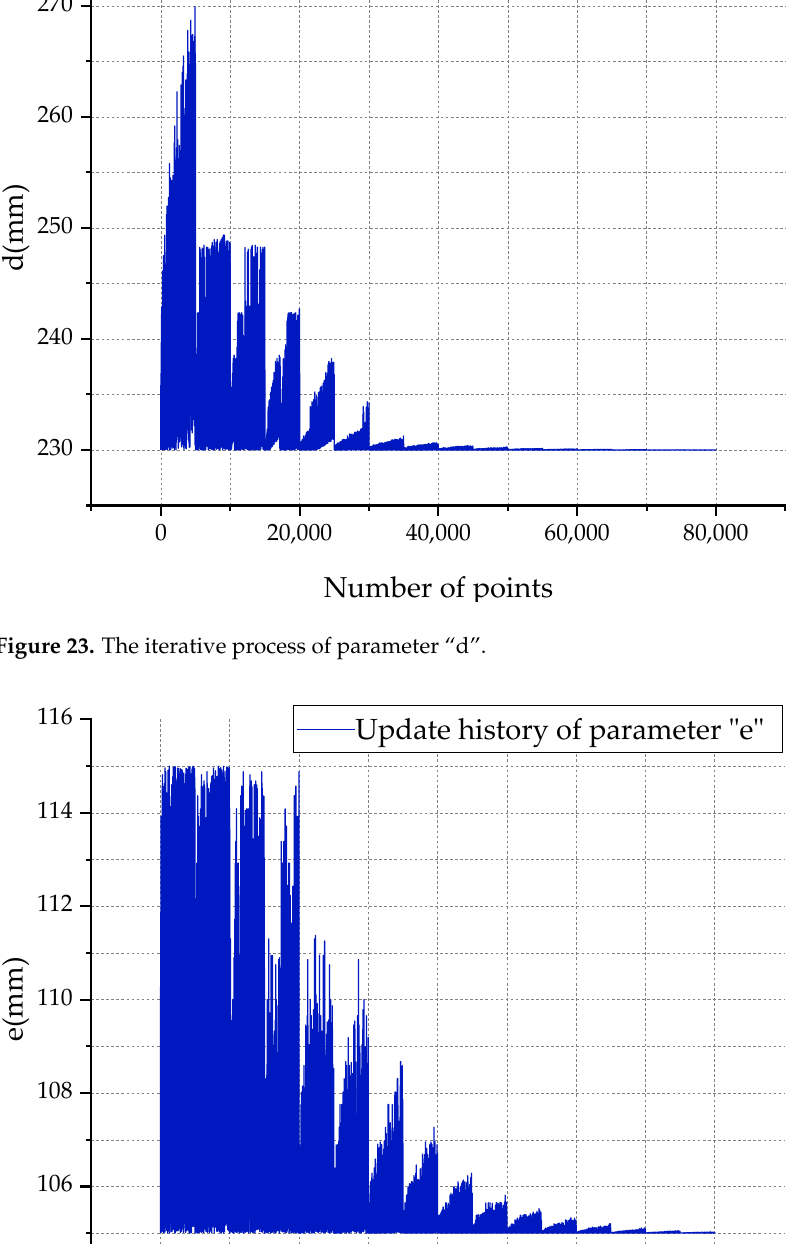
Figure 22. The iterative process of parameter “c”.